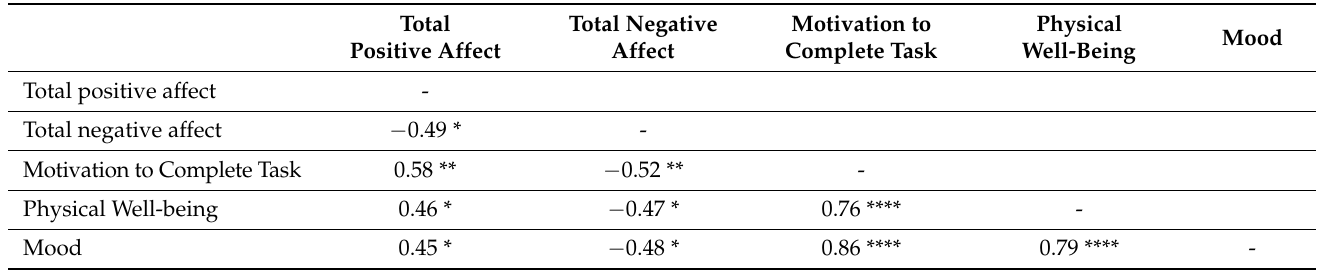
Table 6. The Spearman correlation ( r s ) between aggregated positive and negative affect and three follow-up questions in PANAS EMA. The analysis revealed that mood, motivation to complete tasks, and physical well-being were all highly correlated. PANAS positive affect and negative affect scores are inversely related, as expected. Asterisks (*, **, and ****) indicate p -values < 0.05, 0.01, and 0.0001, respectively.